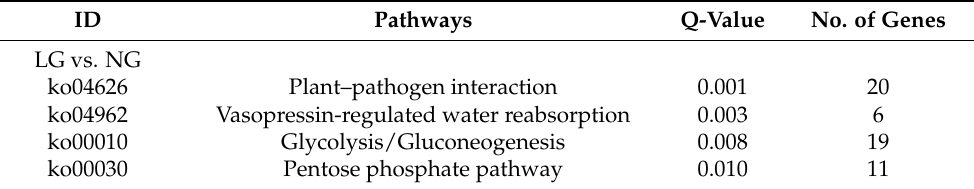
Table 4. Significantly enriched gene pathways involving differentially expressed genes (DEGs) following the grazing